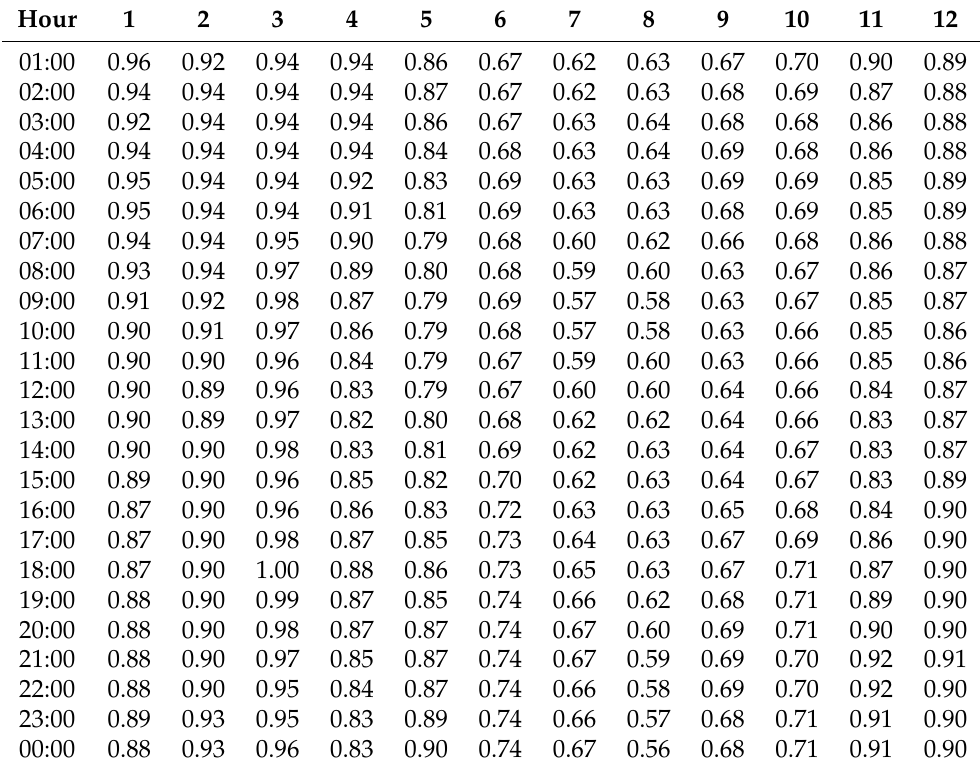
Table A1. Normalized wind power profile (hours/months).